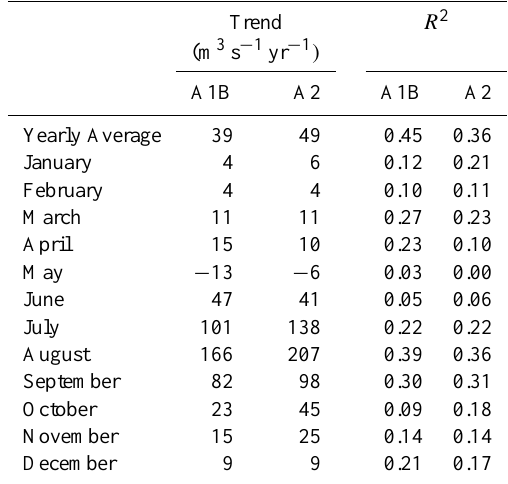
Fig. 6. Flow duration curve for observed and multi-model weighted dischargeof A2 scenario of four different time slices. Table 2. Trends in monthly annual stream flow from 1961 to 2100. Trends and R 2 are first calculated per GCM and subsequently the weighted average calculated. All trends are significant at the 95% confidence level, except for the trend in May discharge for the A2